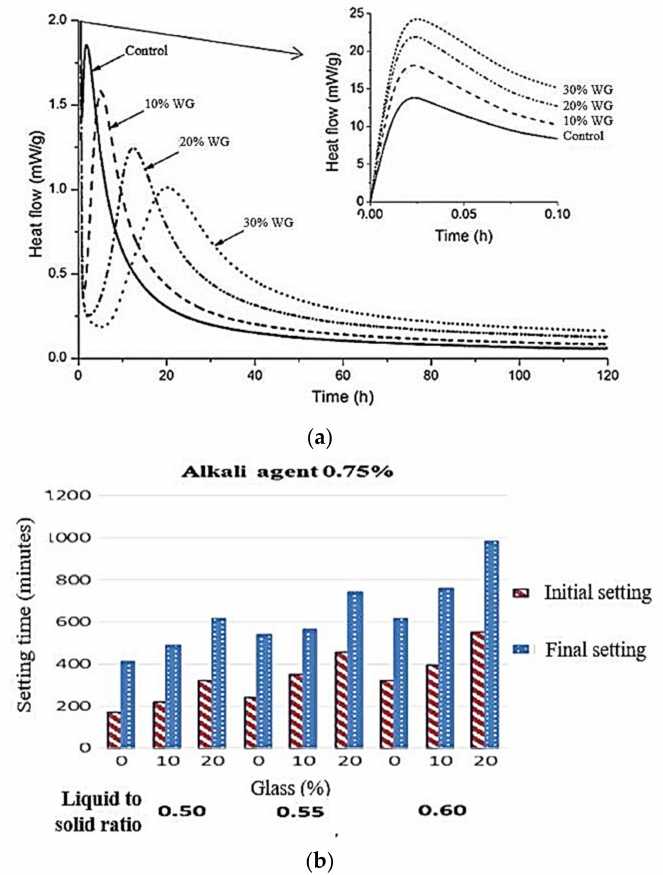
Figure 19. Hydration characteristics of WG powder-based geopolymer concrete. ( a ) Heat flow rate of WG powder-based geopolymer concretes [64] ( b ) Setting time variation in WG powder-based geopolymer concretes